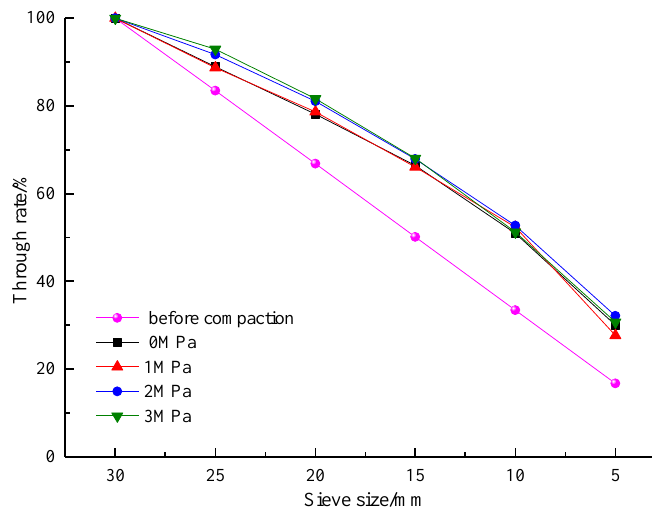
Figure 11. Particle size distributions before and after compaction.